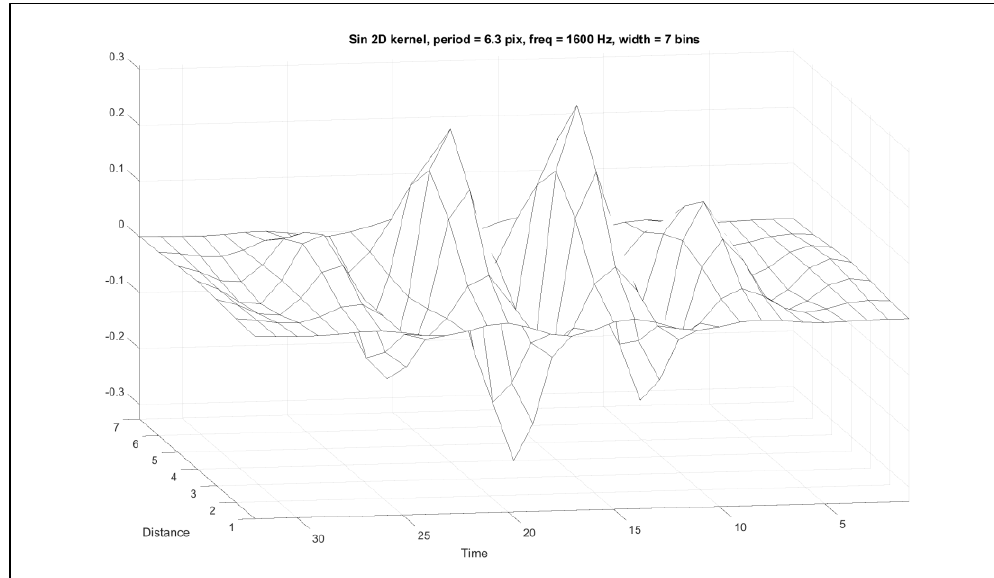
Figure 10. An example of a typical 2-D sinusoidal kernel.